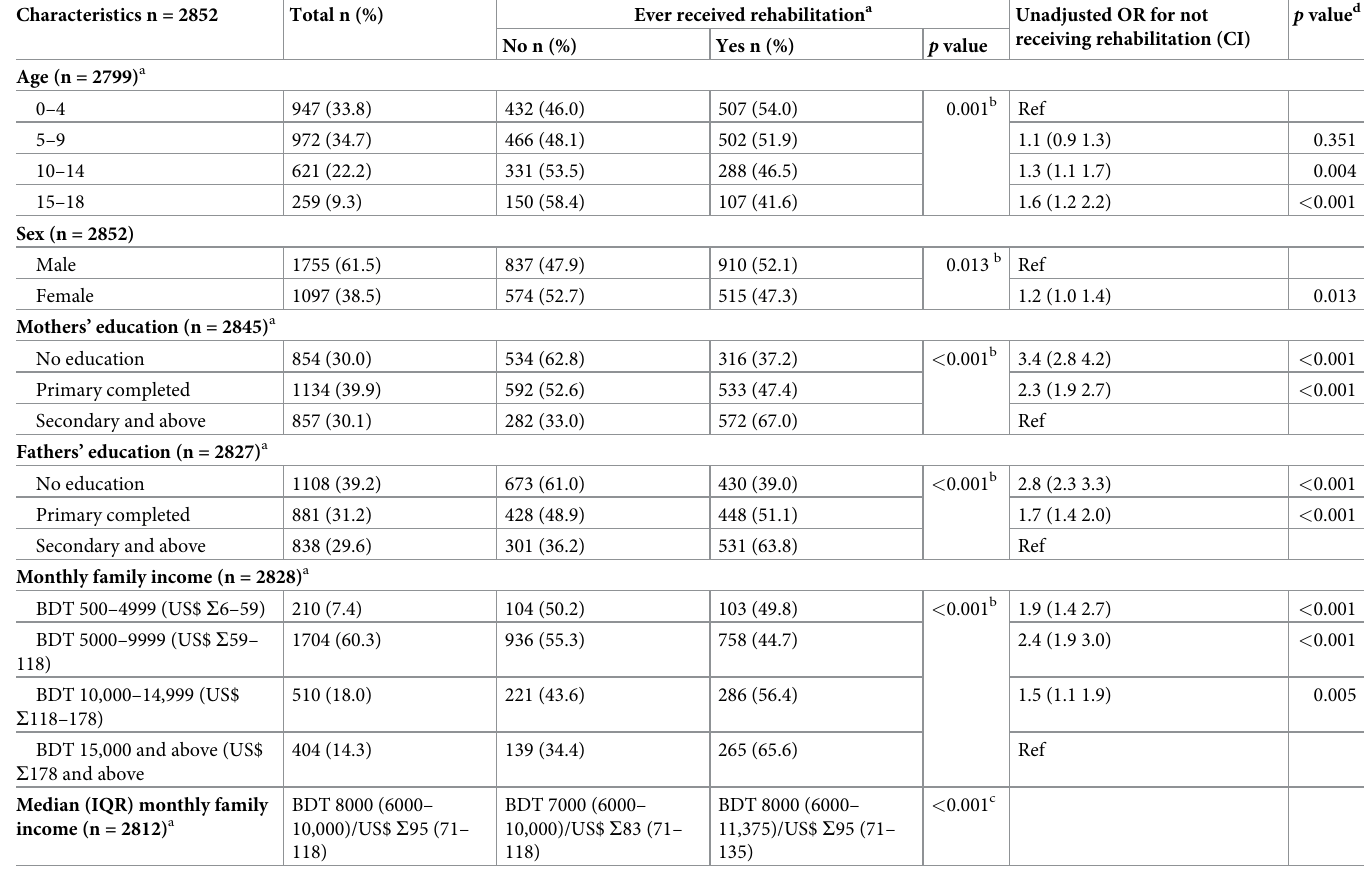
Table 3. Socio-demographic factors related to the receipt of rehabilitation for children with CP in the BCPR cohort. Characteristics n =